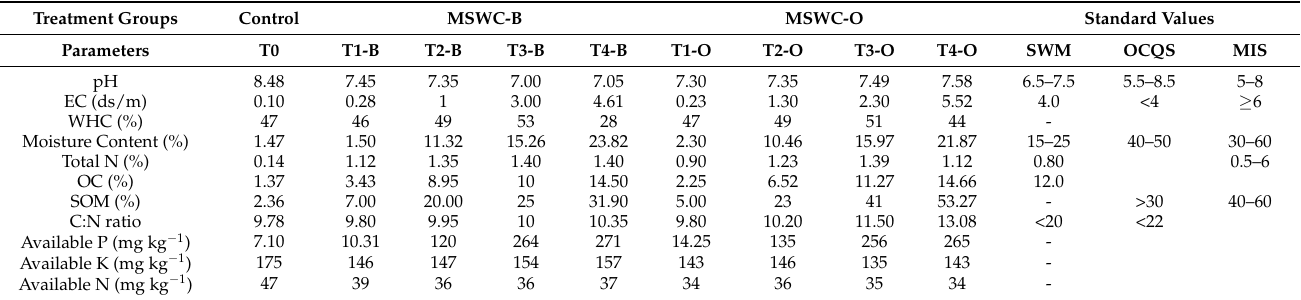
Table 2. Physicochemical characteristics of experimental soil amended with different proportions of municipal solid waste composts.